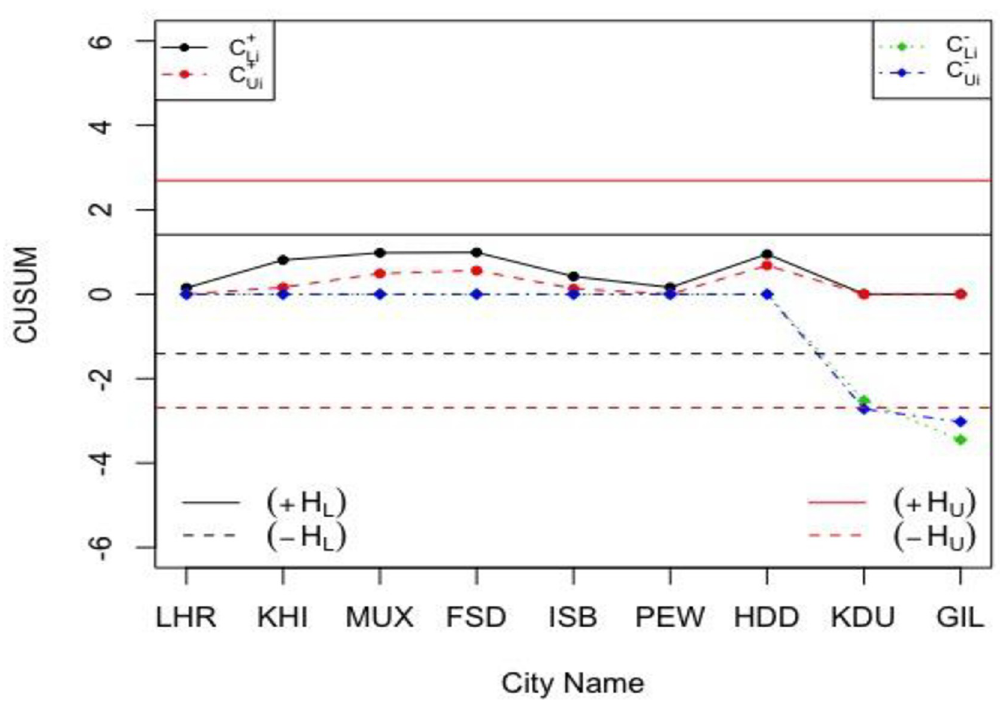
Fig 5. The proposed NCUSUM � X chart for the weather condition in Pakistan with H N 2 [1.4109, 2.6919] and K N 2 [0.1472, 0.2809].